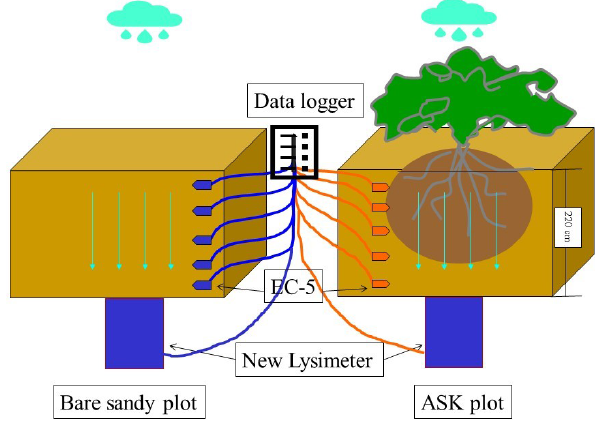
Figure 3. Design of the precipitation–DSR observation